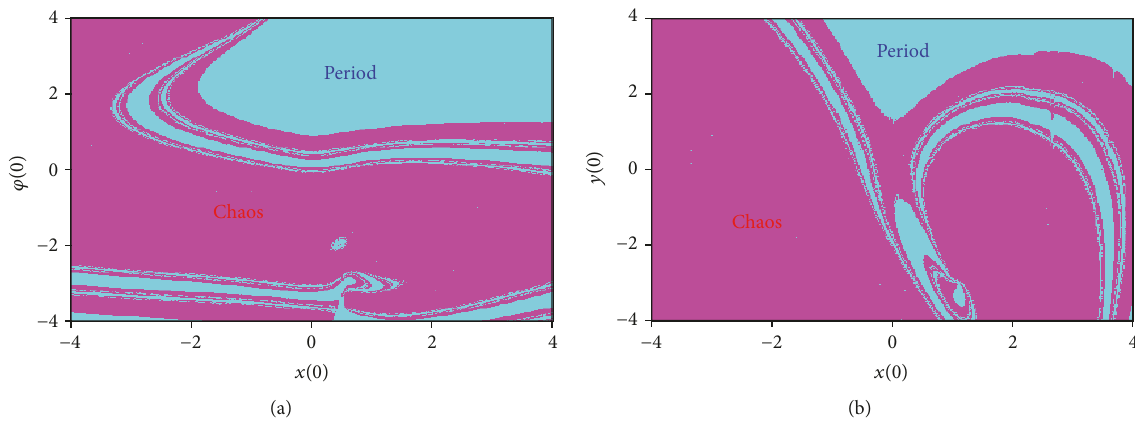
Figure 3: Attraction basins in two different planes for 𝐼 = 1 and 𝑘 = 0.9 , indicating the emergence of bistability phenomenon. (a) The 𝑥(0) - 𝜑(0) plane with 𝑦(0) = 0 . (b) The 𝑥(0) - 𝑦(0) plane with 𝜑(0) = 0 .